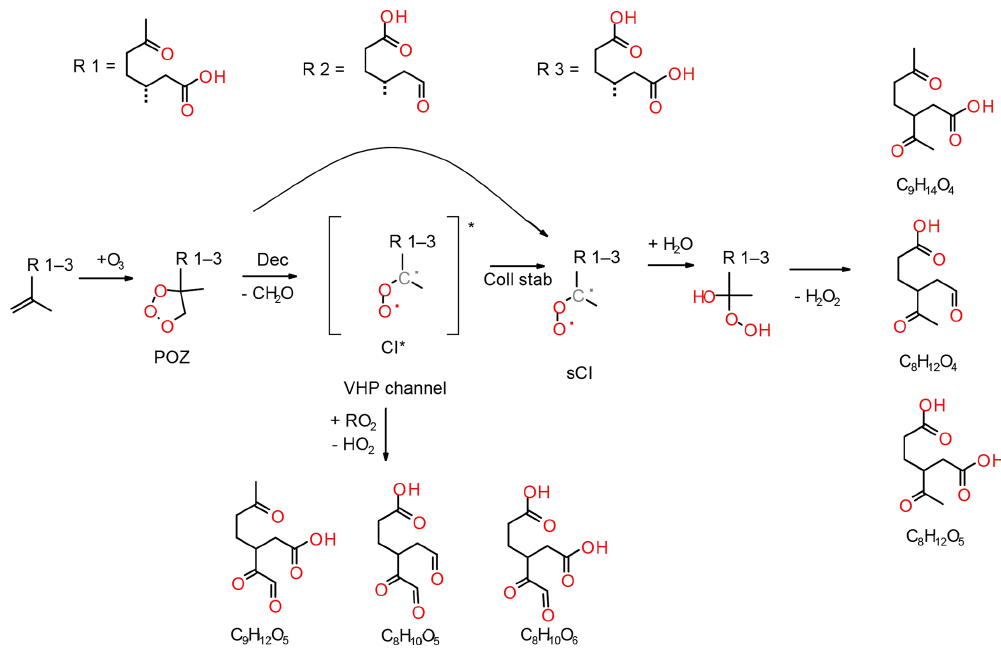
Figure 5. Proposed reaction mechanisms for secondary ozone chemistry of limononic (R1), limonic (R2) and limonalic (R3) acid. The dotted bond shows where R1-3 is connected to the 2-methyl-ethenyl group (i.e. − C ( CH 3 ) =CH 2 ) in the parent compounds.